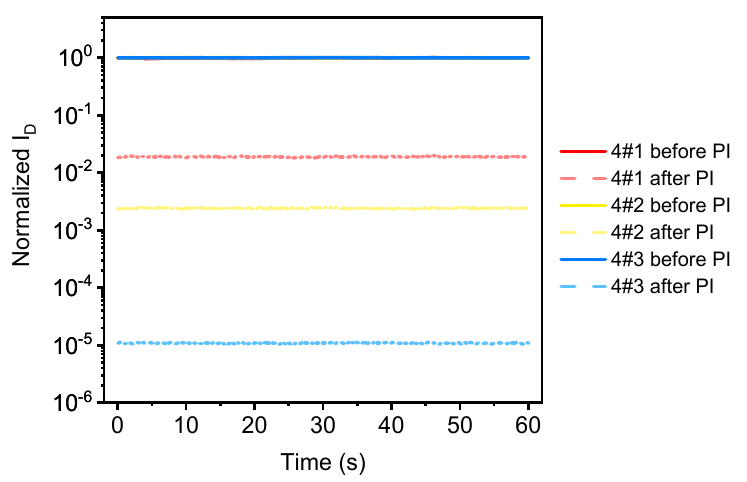
Figure 13. The normalized leakage current of graphene samples varies with the dose of electron irradia- tion.